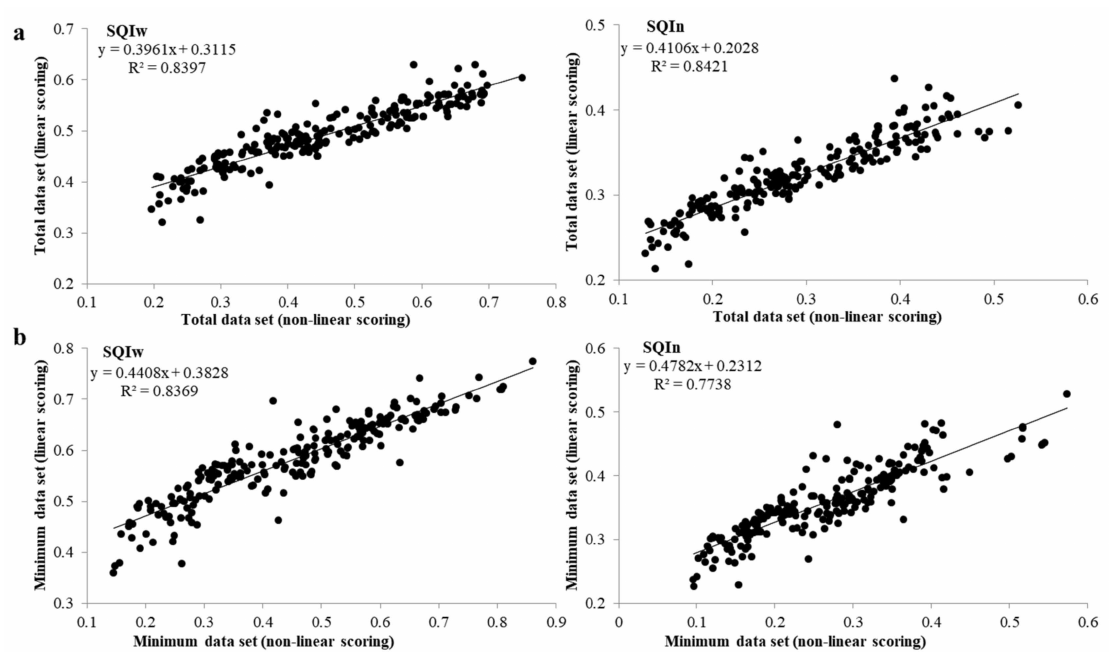
Figure 5. Linear relationships between total data set (TDS) indicator methods and minimum data set (MDS) indicator methods using ( a ) linear and ( b ) nonlinear scoring systems in the nemoro soil quality index ( SQI n ) and weighted additive soil quality index ( SQI w ) models.